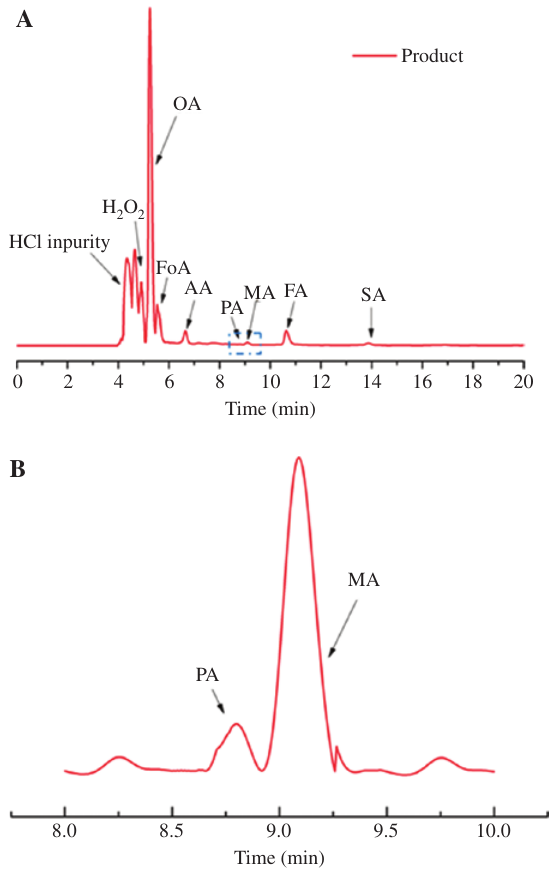
Figure 8: Typical HPLC curve of the product (A), and the enlarge- ment curve of indicated part